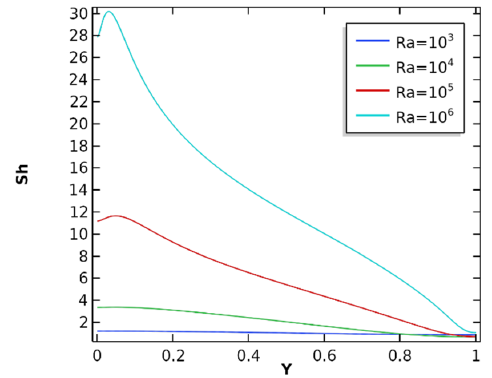
Figure 6. Variation in local Nu and Sh . Table 3. Average Nu and Sh comparison.